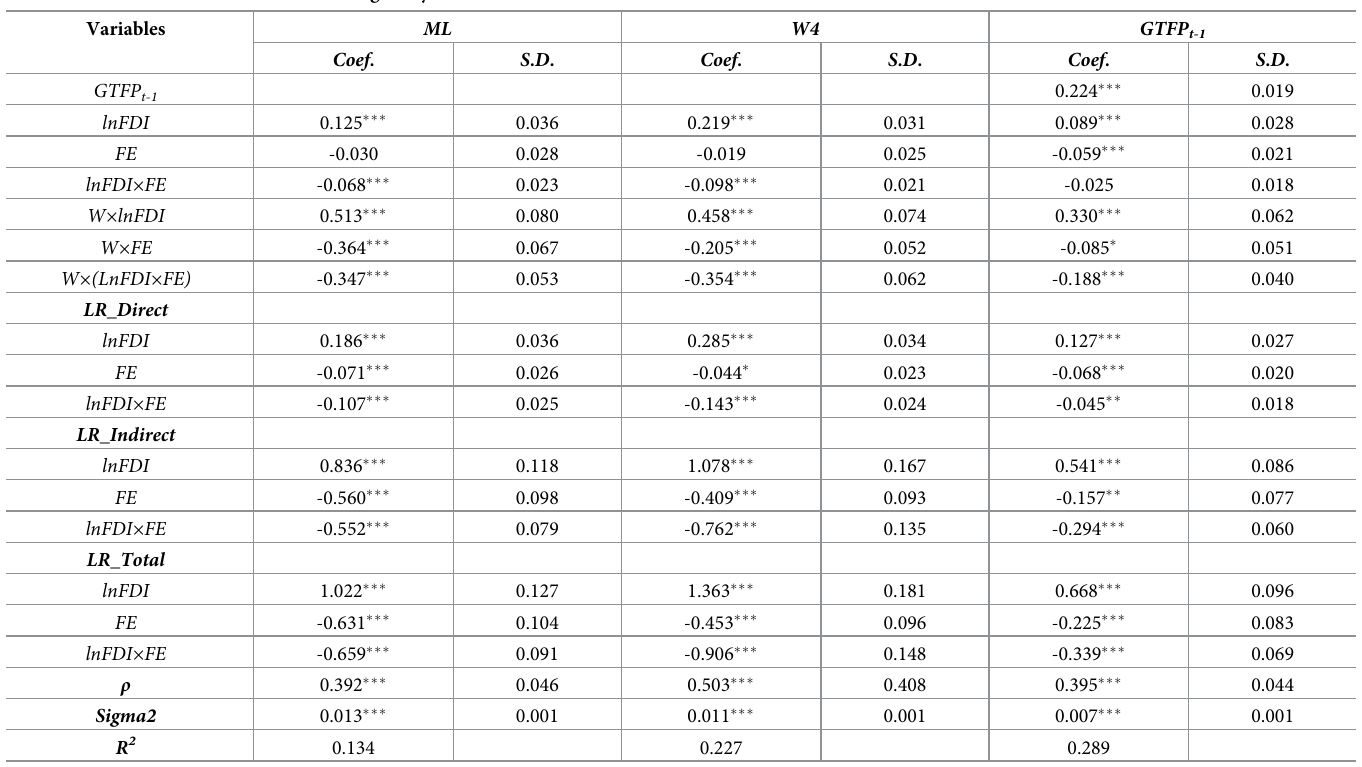
Table 10. The result of robustness and endogeneity